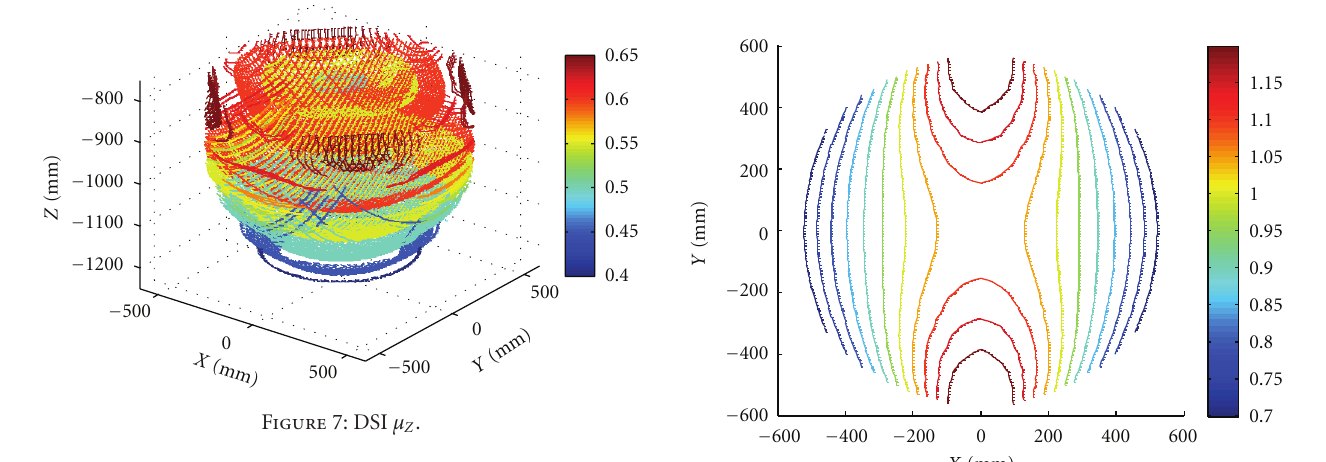
Figure 8: Manipulability index μ t in the XY plane ( Z = − 900).